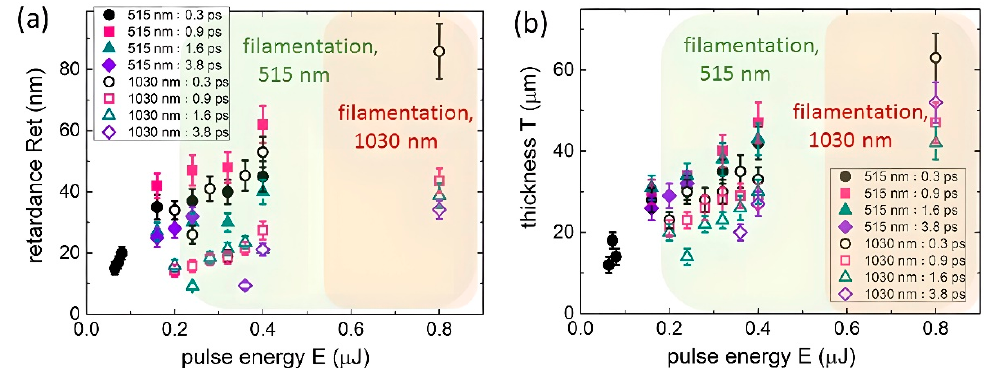
Figure 1. Retardance ( a ) and birefringent microstructure thickness ( b ) values versus pulse energy for different pulse widths (symbols of different shapes and colors) at 515 nm (solid symbols) and 1030 nm (open symbols) wavelengths. The green and reddish highlighted regions indicate the filamentation pulse energy ranges at these wavelengths, respectively, based on experimental results in [20].